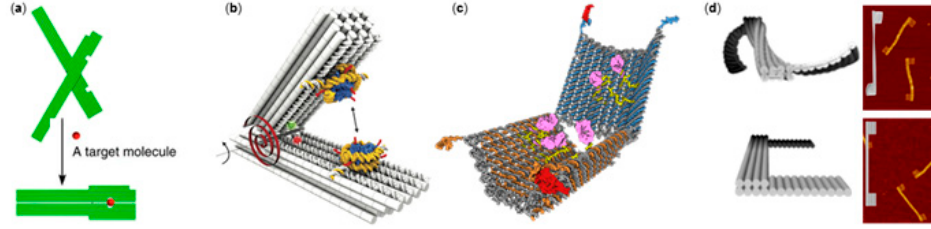
Figure 2. DNA origami devices with molecular interactions. ( a ) DNA origami pliers or forceps that exhibit conformational change upon a target molecule binding [84]; ( b ) A DNA origami measurement device equipped by nucleosomes to probe nucleosome–nucleosome interaction [85]; ( c ) A